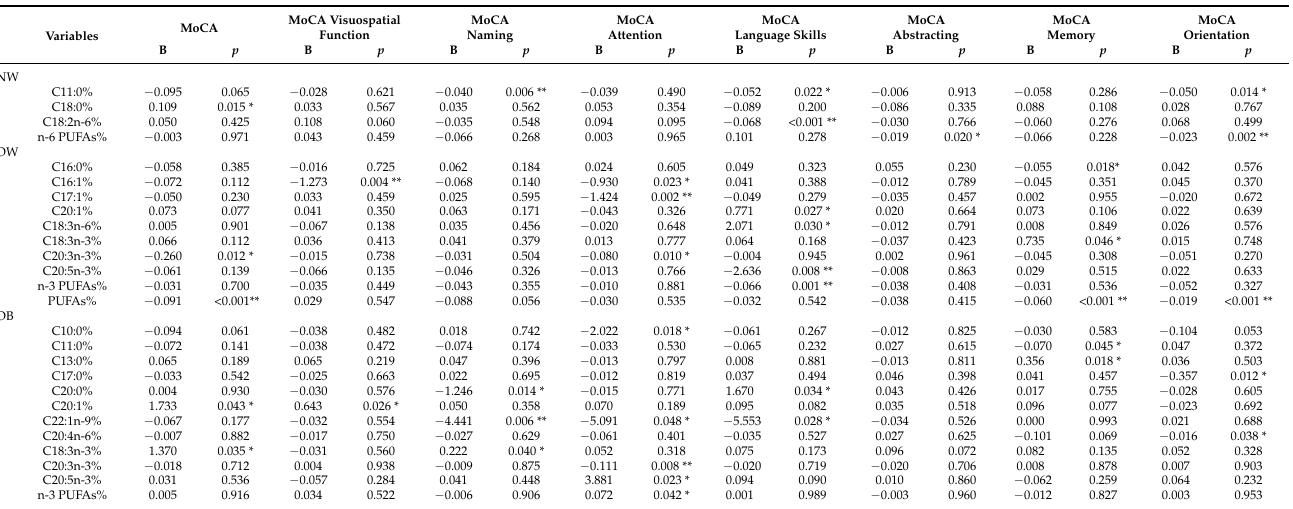
Table 6. Associations between the scores in all of the cognitive domains measured by MoCA and the fatty acid composition of the erythrocyte membranes in the three